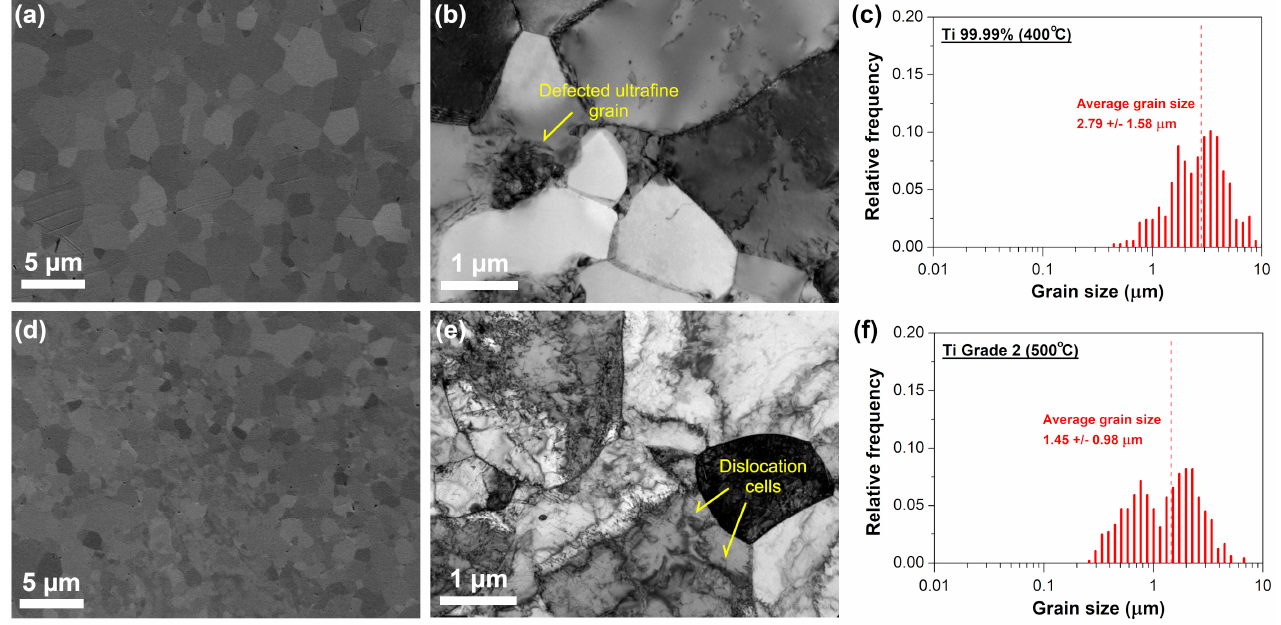
Figure 4. Microstructure of the annealed sheets: ( a , b ) Ti 99.99% at 400 °C and ( d , e ) Ti Grade 2 at 500 °C with the corresponding grain size distributions ( c , f